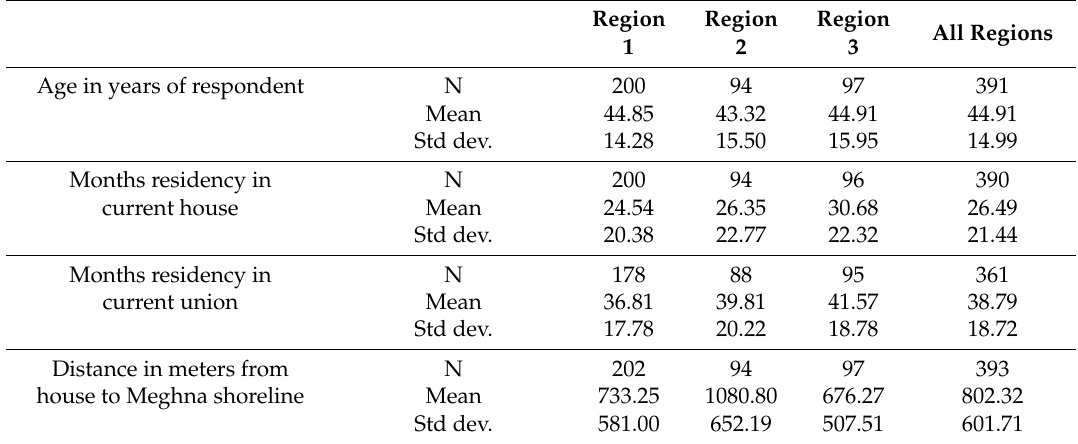
Table A2. Age, residency, and distance characteristics of household respondents and